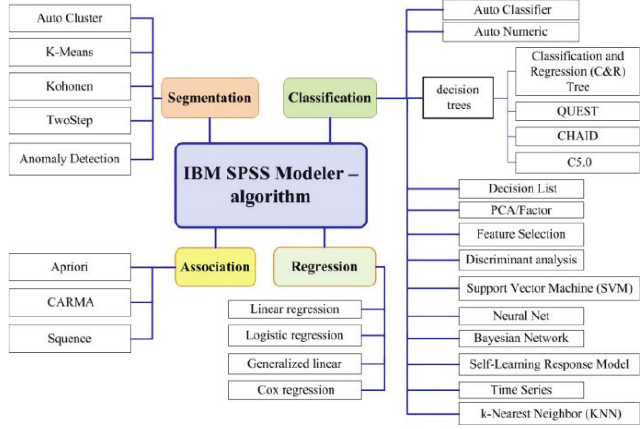
Fig. 4. IBM SPSS Modeler data mining algorithms (IBM Corporation, 2011).